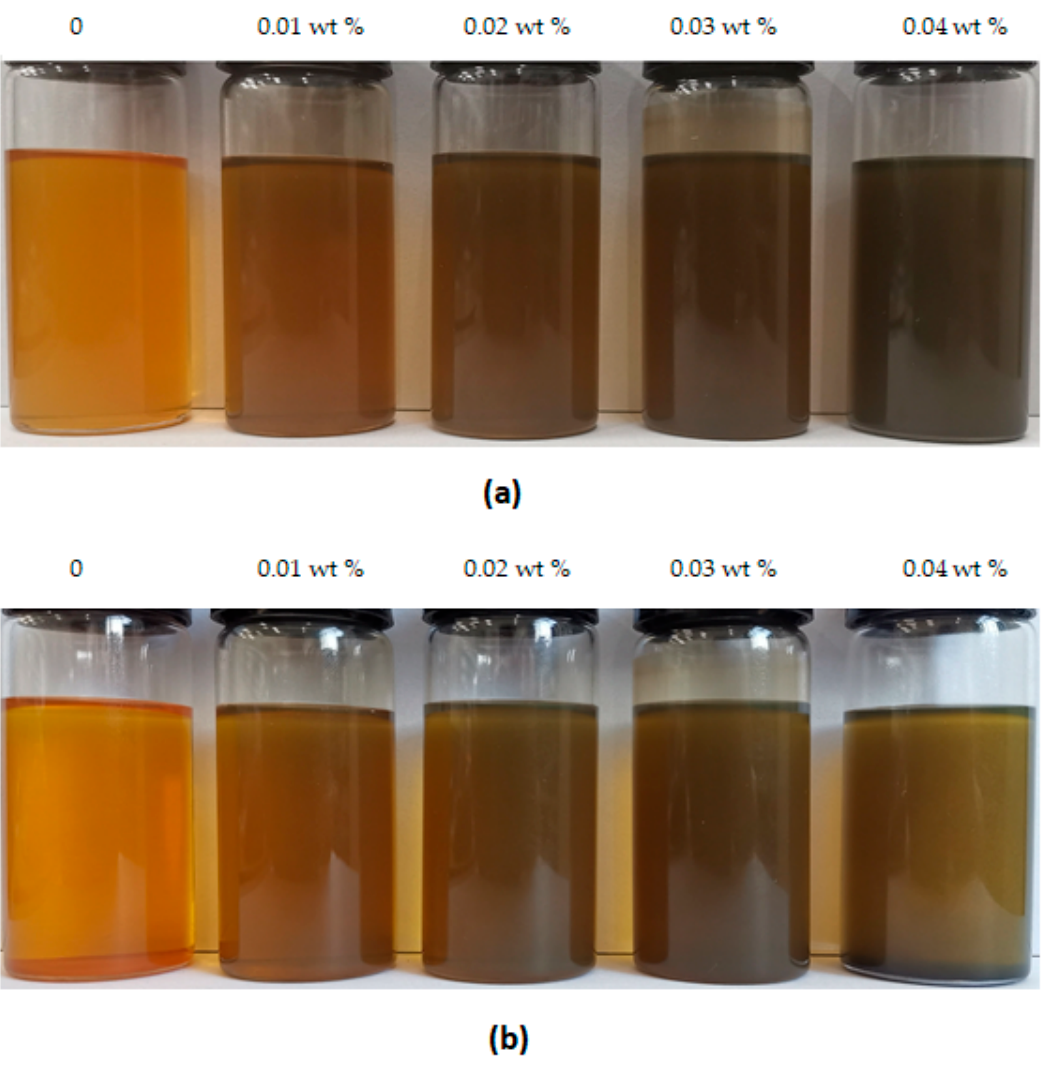
Figure 7. Digital images of 0# diesel oil (oil sample 1) with different concentrations of graphene additives settled for ( a ) 0 days and ( b ) 20 days.